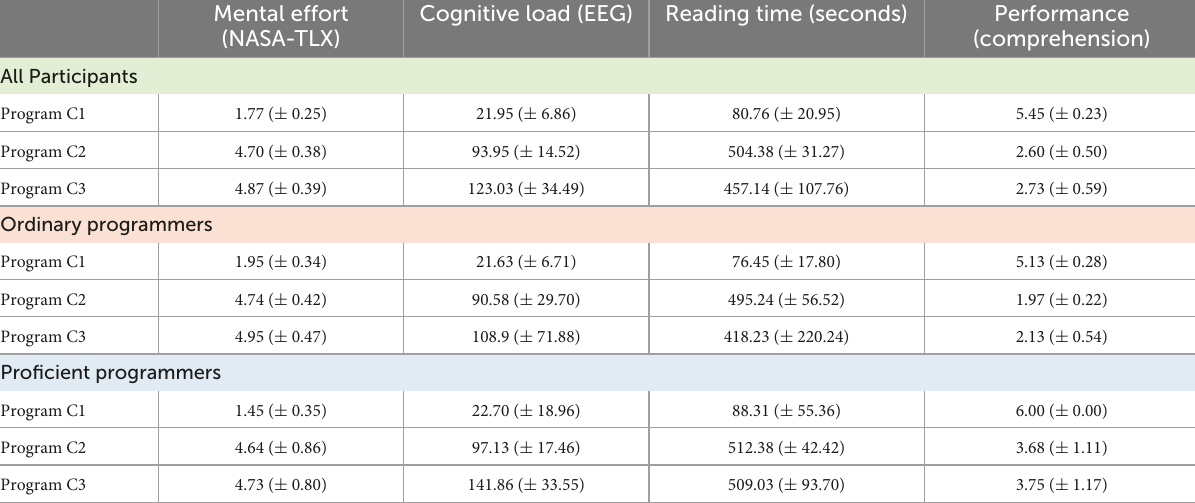
TABLE 5 Average global results: performance, cognitive load, and reading time (95%